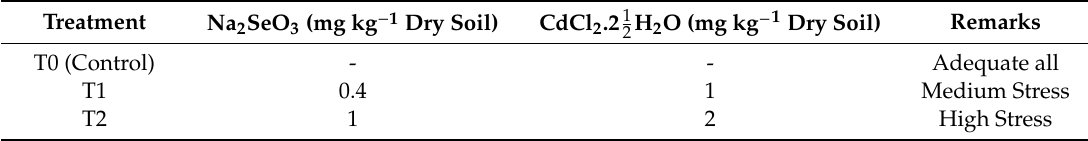
Table 2. Stress treatment groups used in the